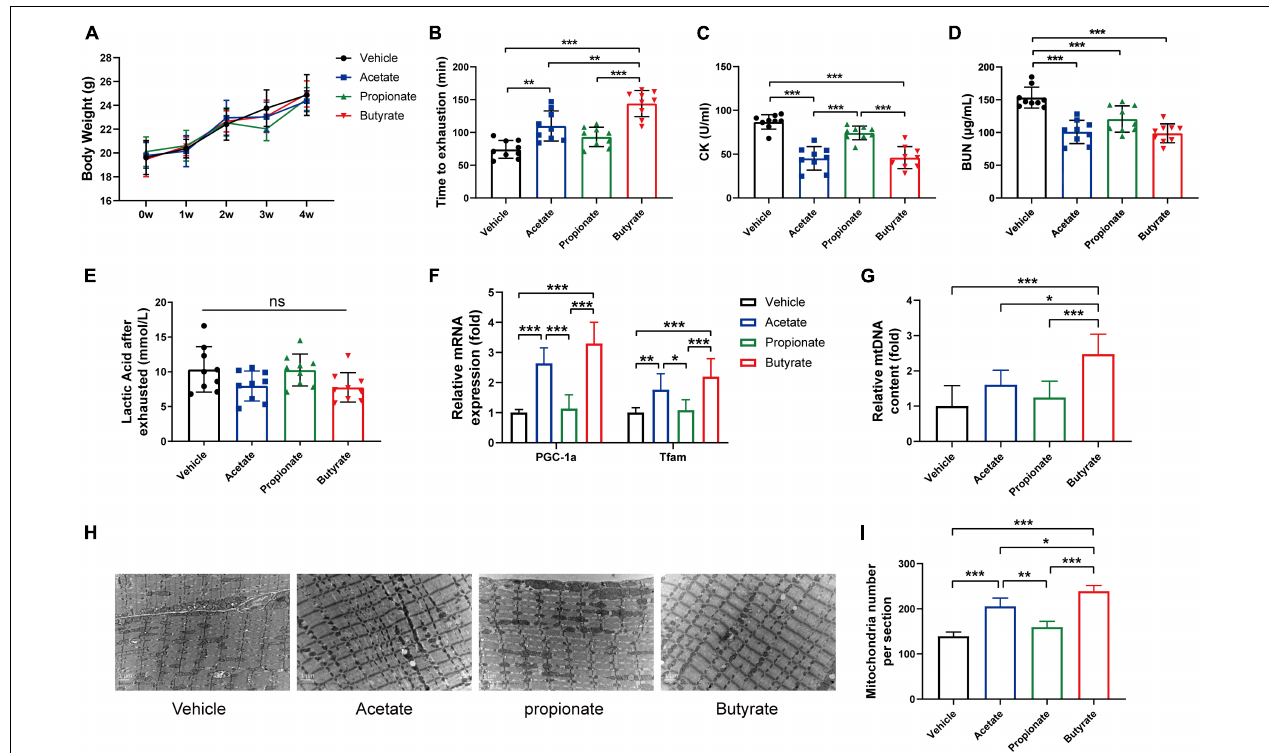
FIGURE 6 | SCFAs supplement enhanced endurance capacity by promoting mitochondrial synthesis. (A) Body weight was measured once a week. (B) Time to exhaustion was recorded. After exhaustion, CK (C) , BUN (D) , and lactic acid (E) were measured immediately. RT-PCR analysis of mitochondrial biogenesis gene expression (F) and mtDNA content (G) in gastrocnemius. Representative TEM images (H) and quantification (I) of mitochondria in gastrocnemius muscle at original magnification of × 12,000. Data are presented as means ± SD. * p < 0.05, ** p < 0.01, *** p < 0.001 (One way